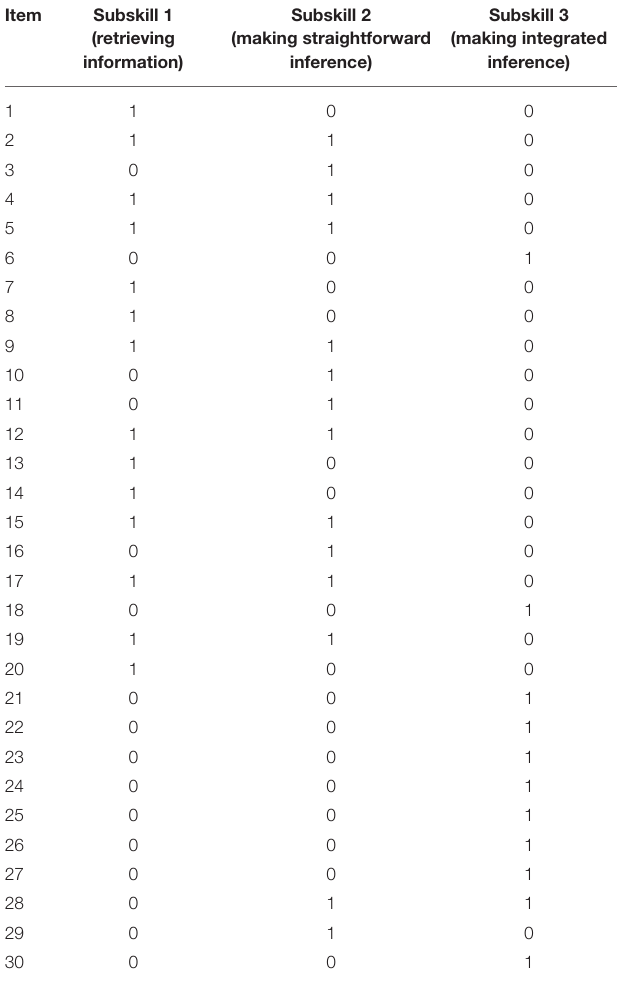
TABLE 1 | Q-matrix for this